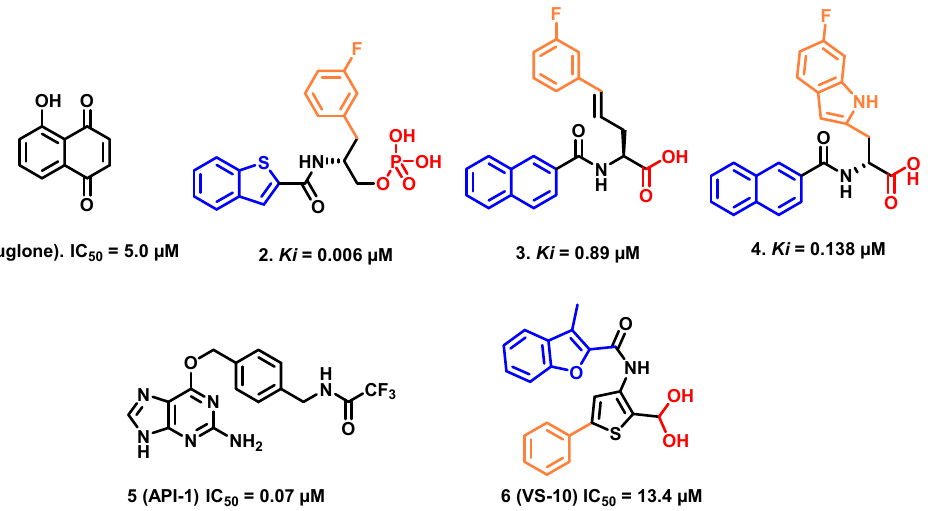
Figure 1. Chemical structures of known Pin1 inhibitors.